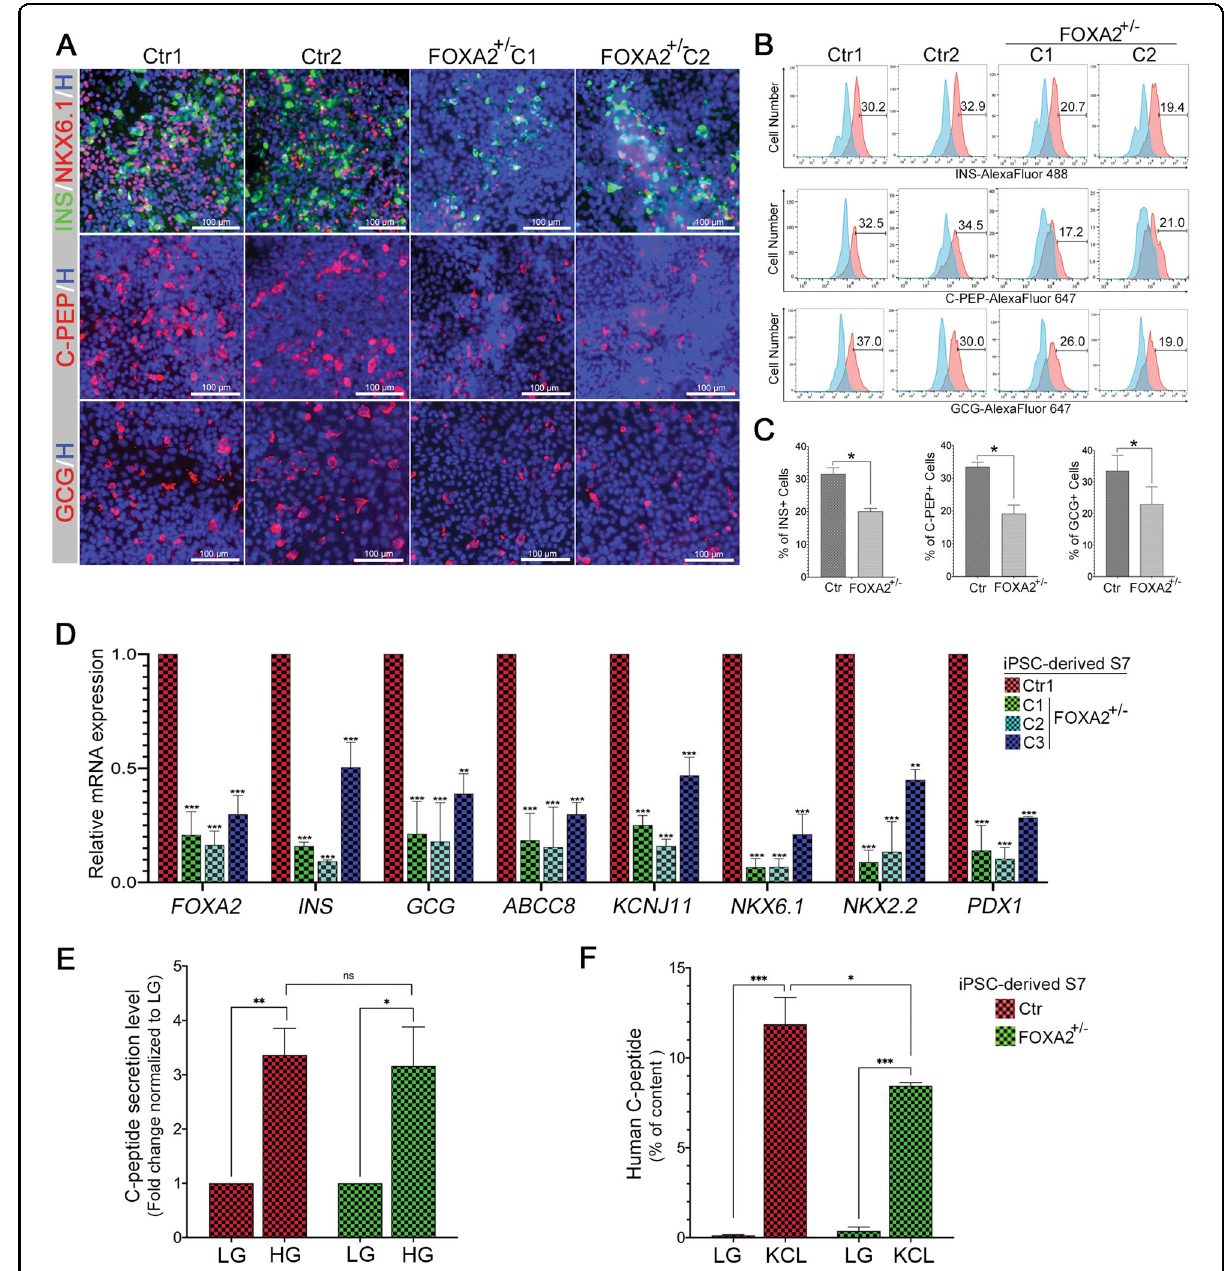
Fig. 6 Effect of FOXA2 haploinsuf fi ciency on iPSC-derived beta cells. Representative immuno fl uorescent images ( A ) and fl ow cytometry histograms ( B ) showing the expression of INSULIN (INS), NKX6.1, C-PEPTIDE (C-PEP), and GLUCAGON (GCG) in stage 7 derived from Ctr-iPSCs and FOXA2 + / − iPSCs. C Flow cytometry quanti fi cation for the data shown in B . D qPCR quanti fi cation for the expression of the pancreatic markers, FOXA2, INS, GCG, ABCC8, KCNJ11, NKX6.1, NKX2.2 , and PDX1 in beta cells derived from Ctr-iPSCs and FOXA2 + / − iPSCs. GSIS assay: fold change of C-PEPTIDE secretion in iPSC-derived beta cells challenged with low (LG; 2.8 mM) and high glucose (HG; 20 mM) ( E ) or stimulated with or without 30 mM KCl in the presence of LG ( F ). Data are represented as mean ± SD; * p < 0.05, ** p < 0.01, *** p <